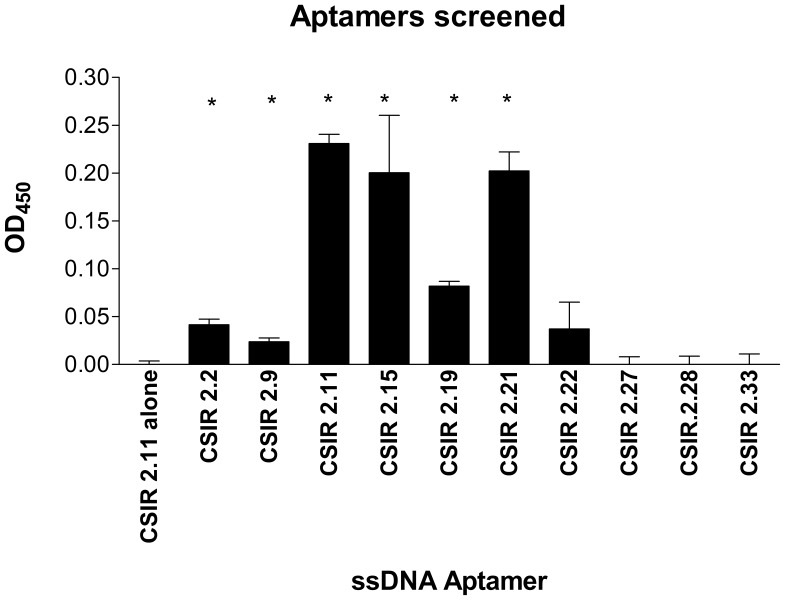
Binding affinity of ssDNA aptamers to the CFP-10.ESAT-6 heterodimer.Results are shown for a selection of biotinylated ssDNA aptamers. Biotinylated ssDNA aptamers that bound significantly (p<0.05) to the heterodimer in an ELONA assay are denoted by the asterisks. Data are presented as means ± standard deviation of the mean.